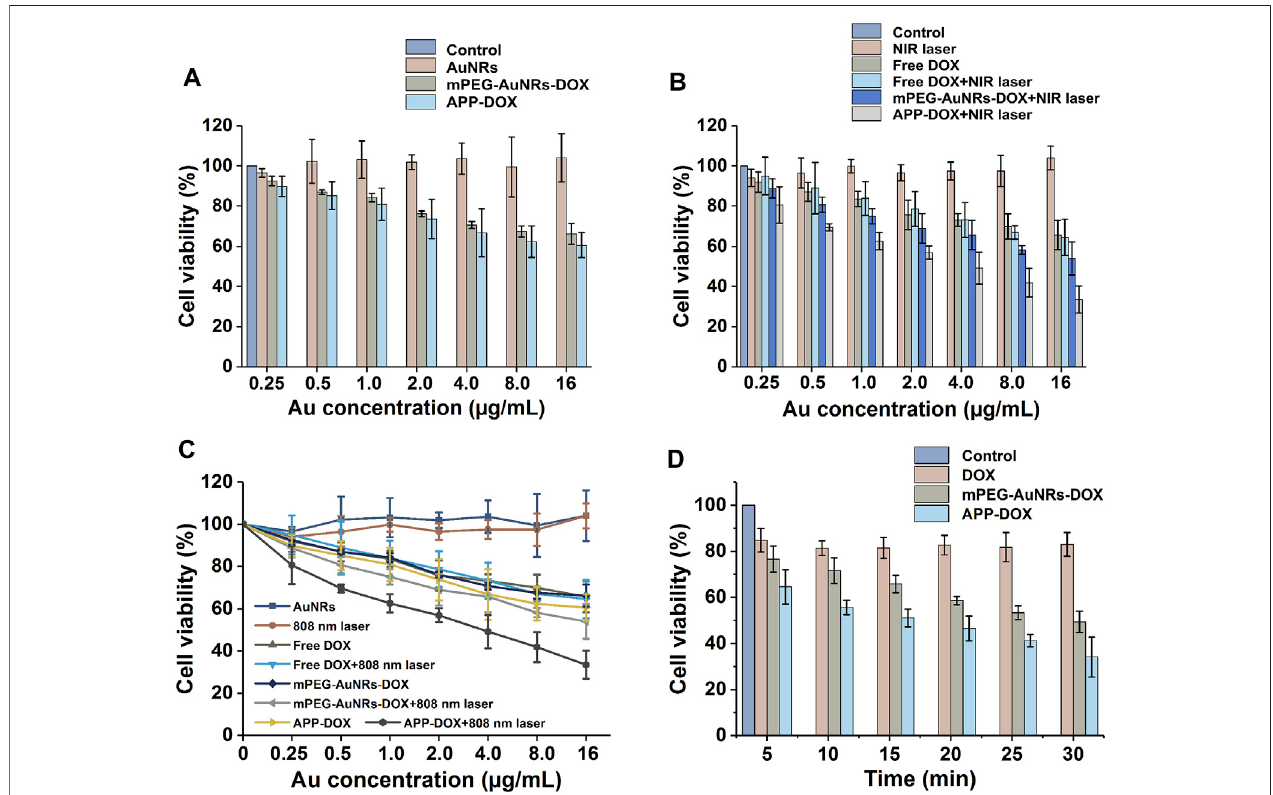
FIGURE 4 | Numerical histogram (A,B) and broken-line graph (C) of HepG2 cells viability after treatment with nanomaterials under laser irradiation and the histogram of the relationship between laser irradiation time and cell survival rate (D) .